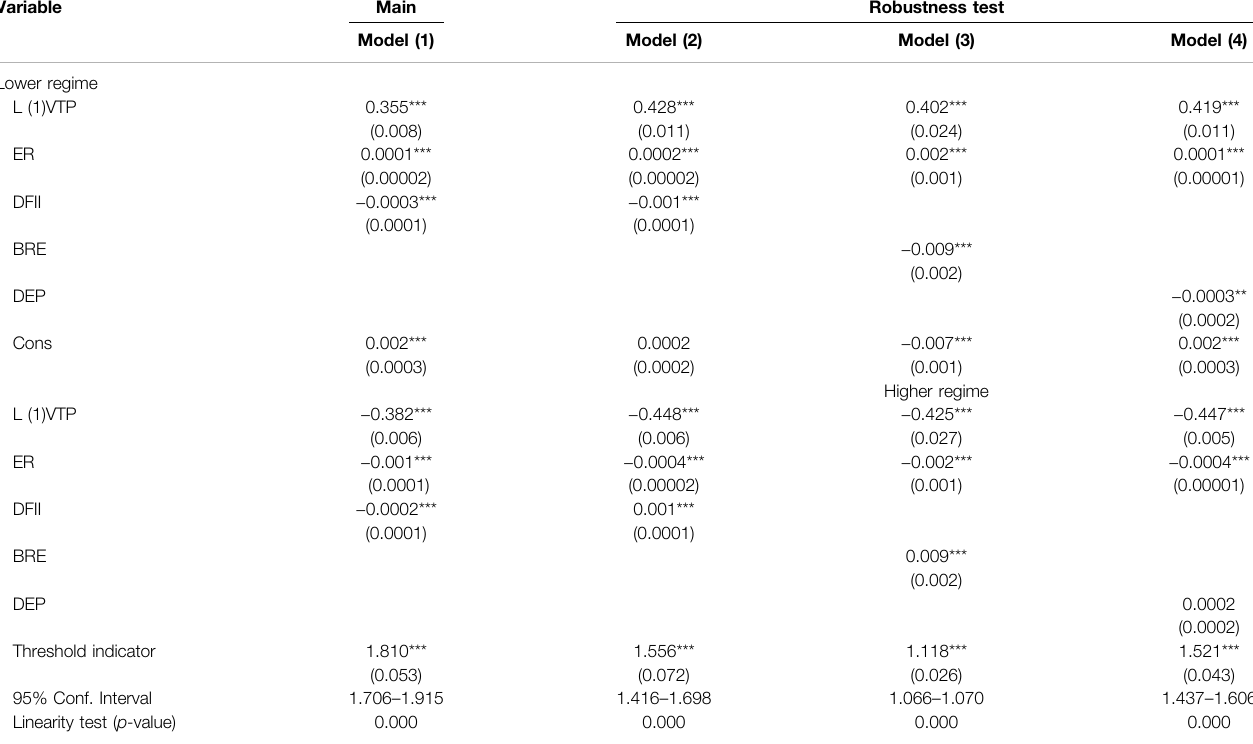
TABLE 7 | Results for the dynamic threshold regression results.